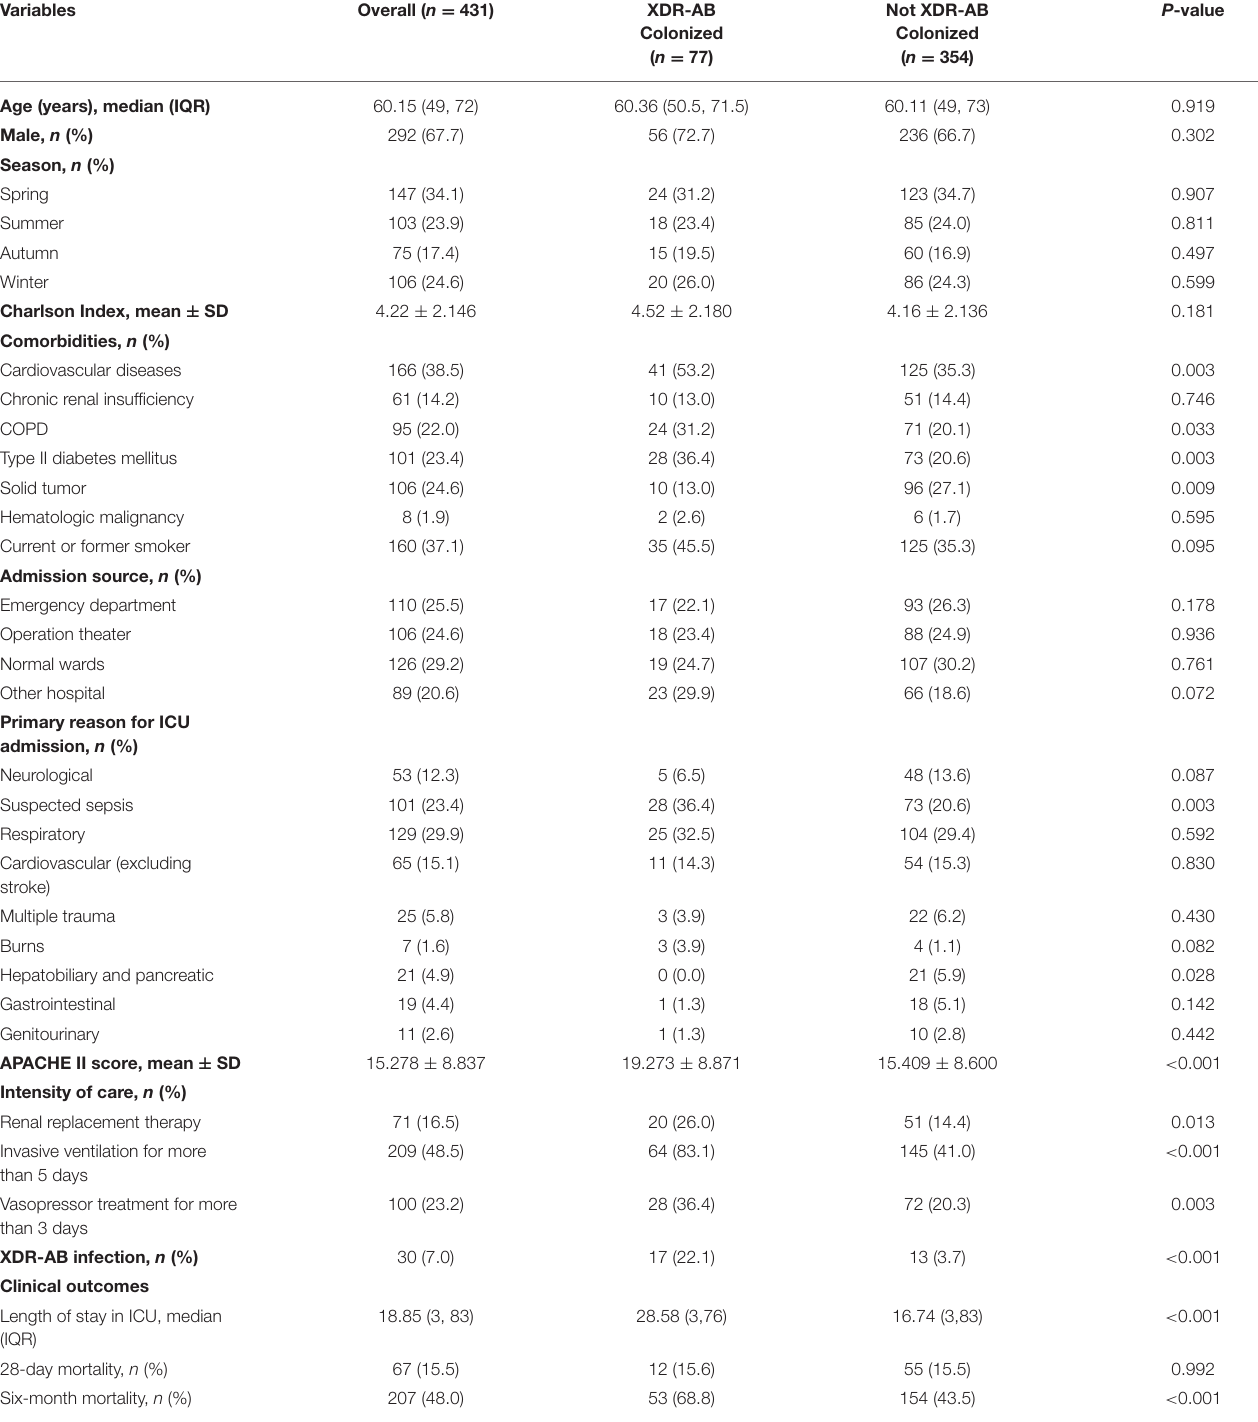
TABLE 1 | Descriptive results of potential risk factors and